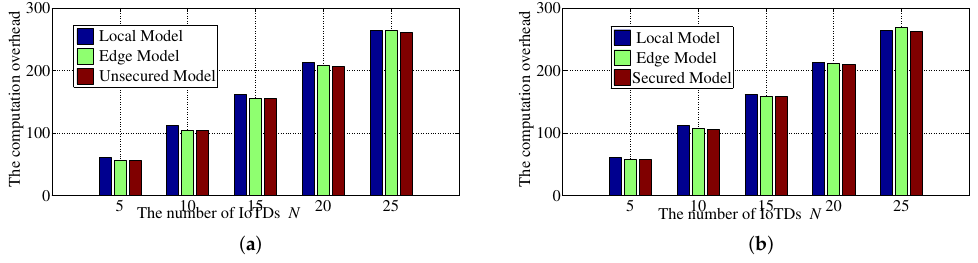
Figure 6. The computation overhead. ( a ) Unsecured model; ( b ) Secured model.